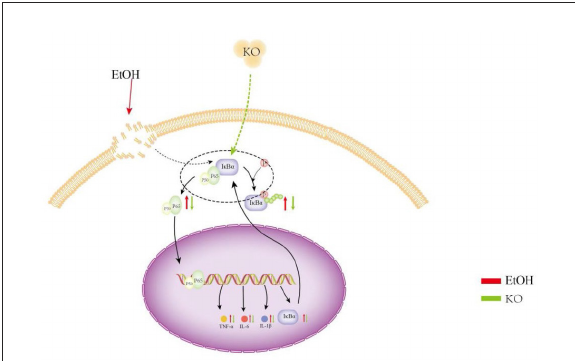
FIGURE6 Protective effect of KO on gastric mucosa injury suffered from ethanol and subsequent inflammatory mediators. Under the induction of ethanol, gastric tissue generates a large number of ROS, which causes oxidative stress. Oxidative stress causes lipid peroxidation and an inflammatory reaction. Lipid peroxidation and inflammation further aggravates oxidative stress. Therefore, in this study, oxidative stress and lipid peroxidation increased MDA, NO, and MPO content in the control, whereas the content of SOD decreased. The activation of the NF- κ B signaling pathway and the high production of inflammatory factors TNF- α , IL-1 β , and IL-6 caused severe inflammation. Oxidative stress, lipid peroxidation, and inflammation interact to promote gastric mucosal injury and gastritis and lead to gastric ulcers and